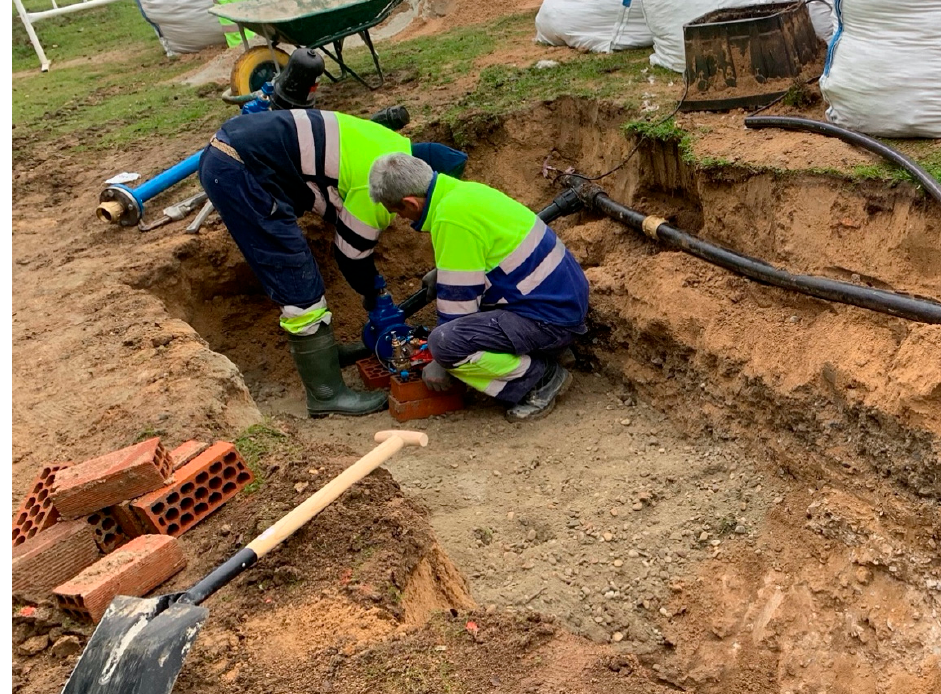
Figure 1. Workers finishing hydraulic pump placement in civil work for water conduction. The work had to be performed in pairs without a safe distance (author’s photograph).